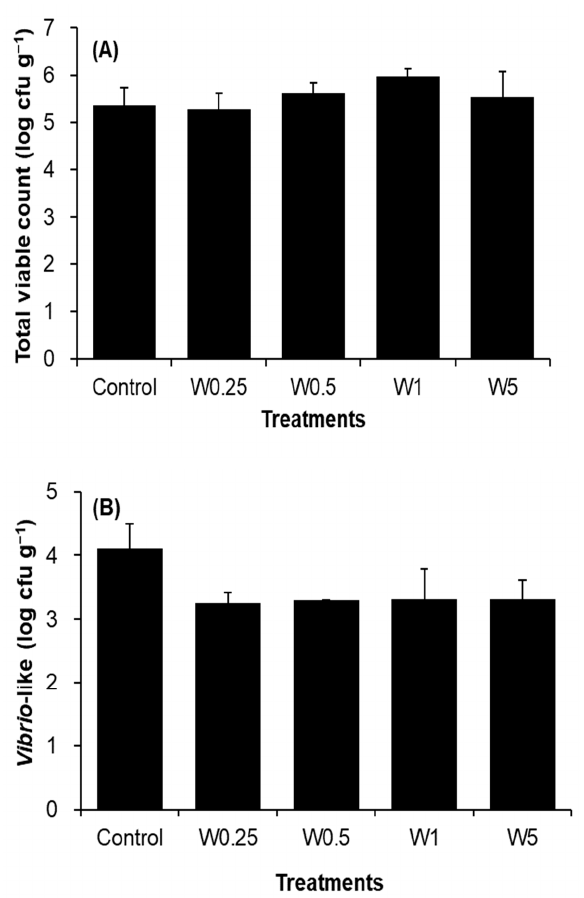
Figure 4. Total viable count ( A ) and Vibrio -like count ( B ) in intestines of shrimp reared in the water added with Micro-Aid Liquid 10 once per week at the levels of 0 (control), 0.25 mL m 3 − 1 (W0.25), 0.5 mL m 3 − 1 (W0.5), 1 mL m 3 − 1 (W1) and 5 mL m 3 − 1 (W5), respectively. n =